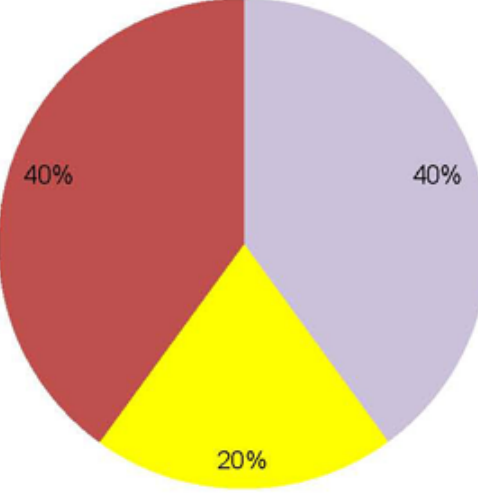
Figure 14: Activity types (by overarching group) predominantly concerned with systems level and the mechanisms used (shown as